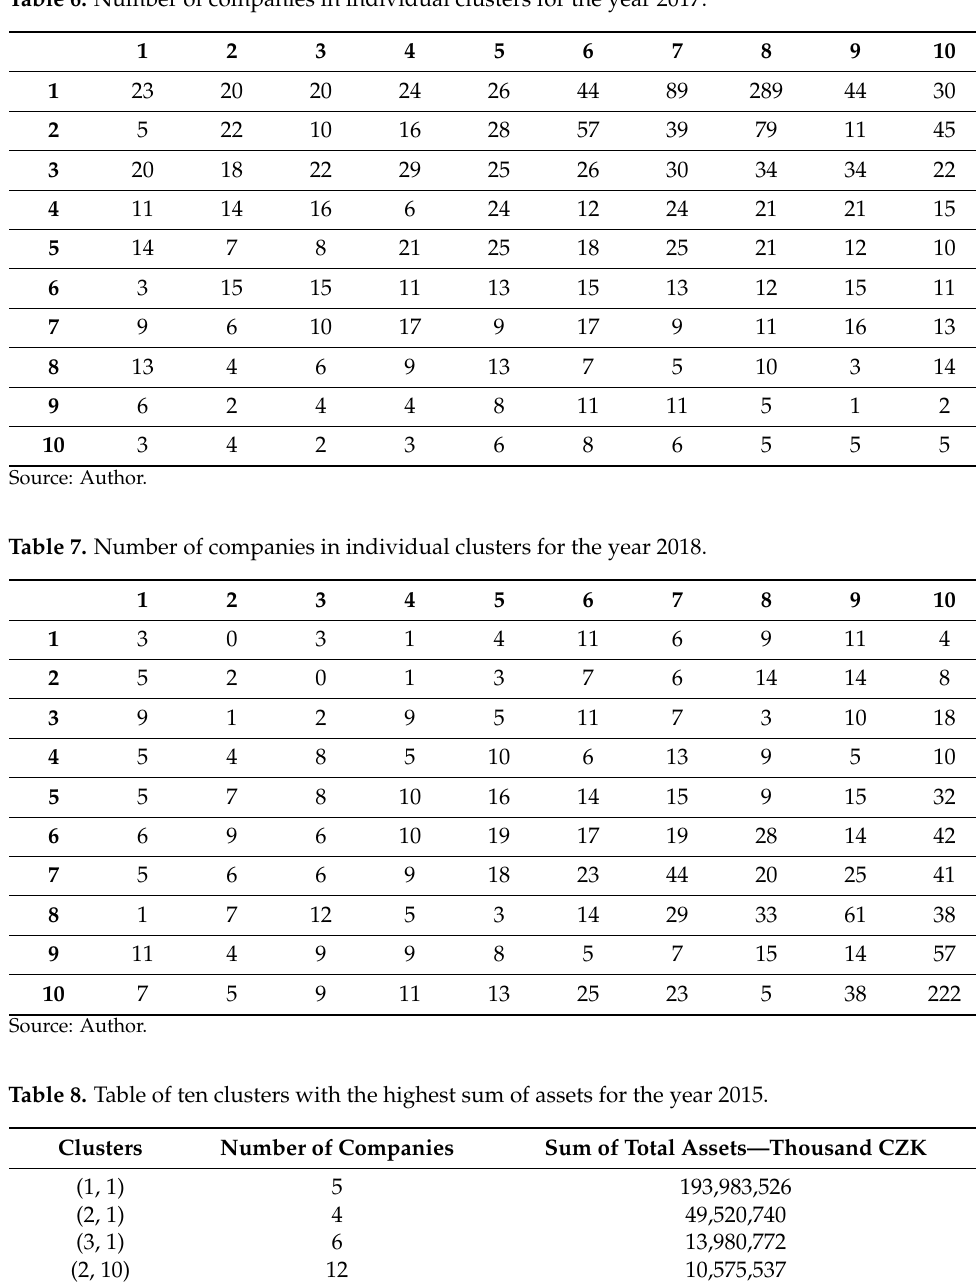
Table 6. Number of companies in individual clusters for the year 2017.